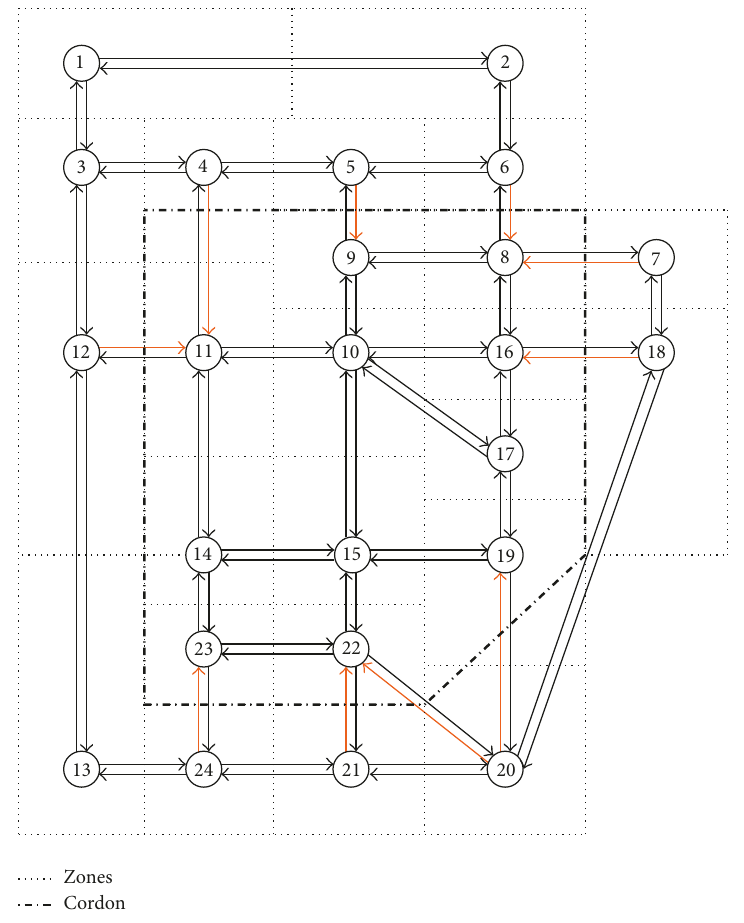
Figure 3: Sioux Falls City network, divided into traffic zones, and cordon road pricing